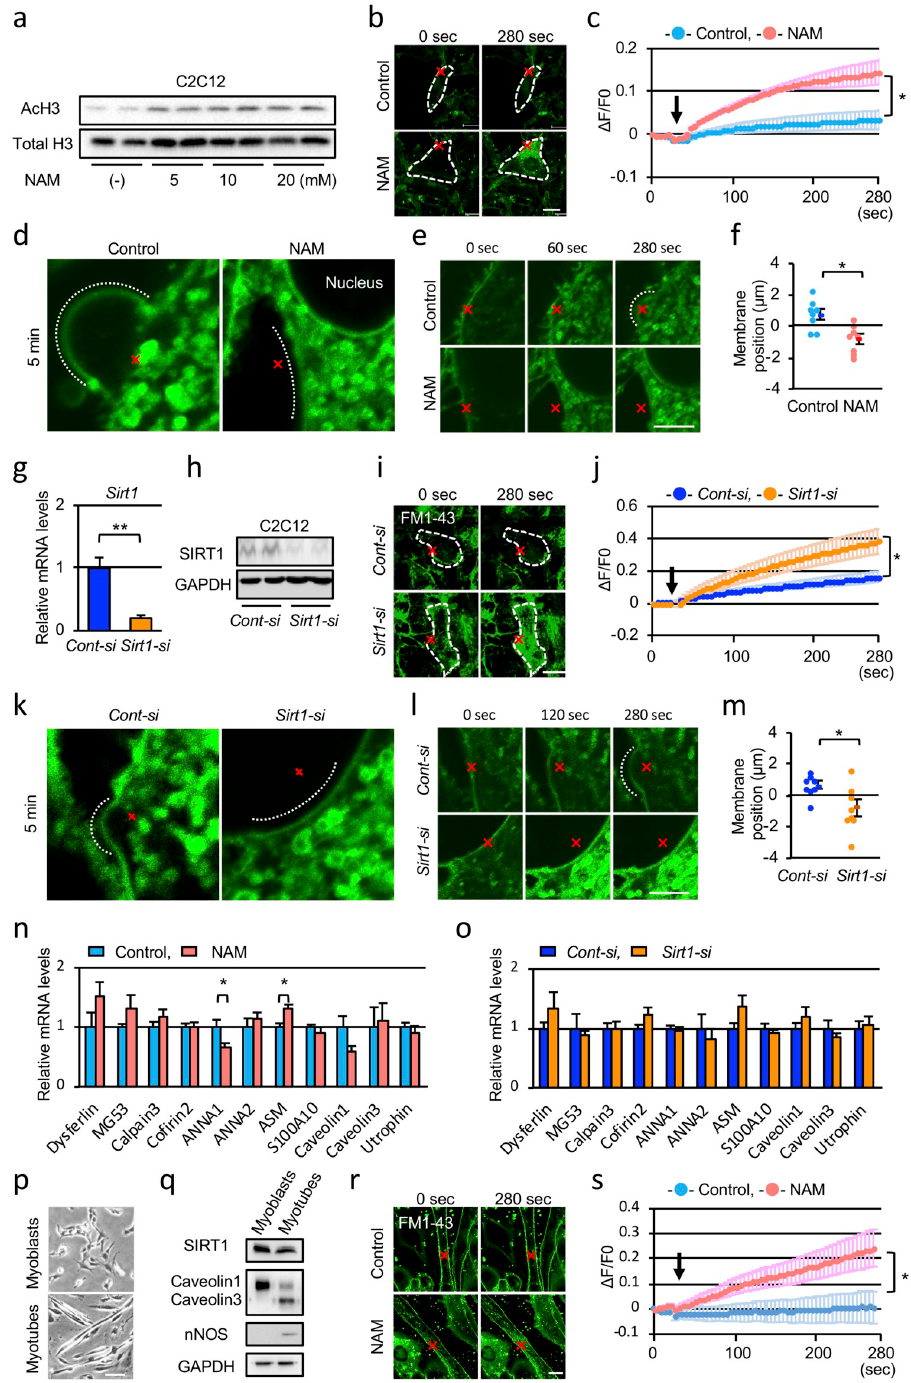
Fig 3. SIRT1 inhibition and SIRT1 knockdown inhibit membrane resealing in C2C12 cells. (a) Immunoblots of acetylated (top) and total (bottom) histone H3 in C2C12 cells 12 h after treatment with various concentrations of nicotinamide (NAM). (b) Plasma membrane repair kinetics upon laser injury measured by membrane impermeable FM1-43 dye influx (green). Representative images before and after laser injury of control (top) and NAM (bottom) treated C2C12 cells. X-marks (red) indicate laser injury points and dotted lines (white) indicate cellular shapes. (c) Time course of FM1-43 dye influx after laser injury in C2C12 cells treated with PBS or NAM (n = 6). Arrow indicates the time point of membrane injury. (d) Enlarged images of the cells 5 min after laser injury. The dotted curves indicate convex (Control) and concave (NAM) membrane 5 min after laser irradiation, respectively. (e) Representative high-